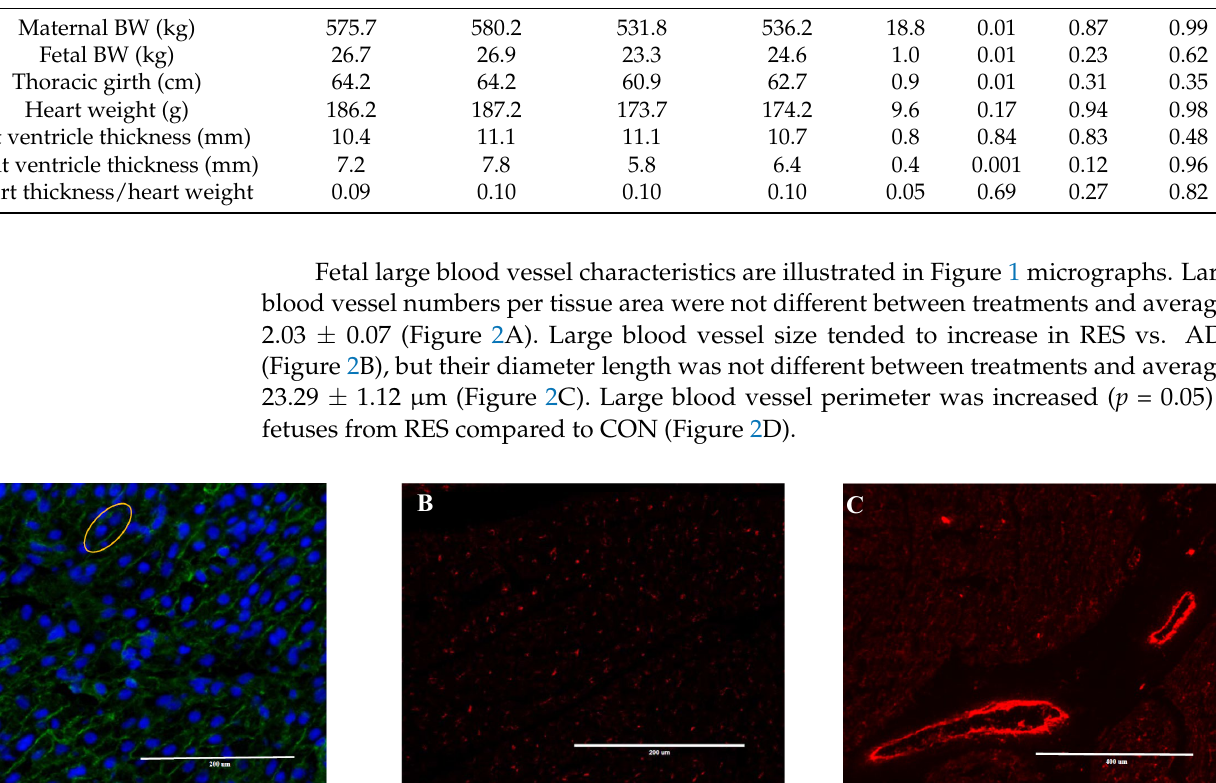
Figure 1. Representative immunofluorescence images of 8-month old fetal cardiomyocytes. Cryosectioned cardiomyocytes were stained for ( A ) cell wall using WGA (Alexa Fluor 488) and nuclei (blue, DAPI) with yellow circle showing binucliated cell, ( B ) capillaries, and ( C ) large blood vessels with CD31 (red, Alexa Fluor 594)). The white scale bar represents 200 μm for figures A and B and 400 μm for figure C .